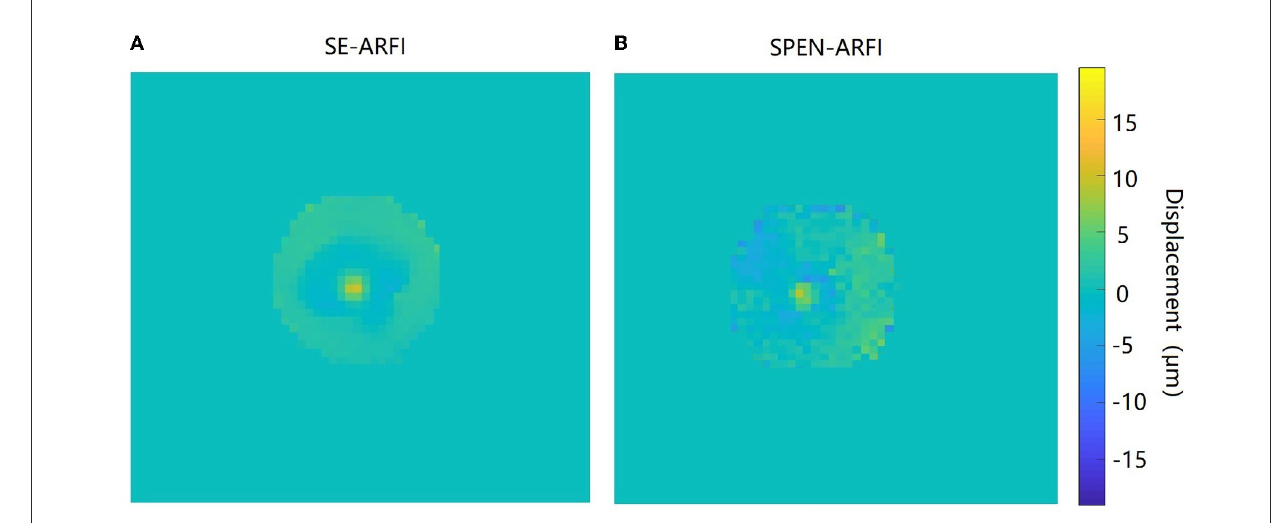
FIGURE8 Comparison of SE-ARFI and SPEN-ARFI sequences. (A) Displacement map obtained by SE-ARFI. (B) Displacement map obtained by SPEN-ARFI.